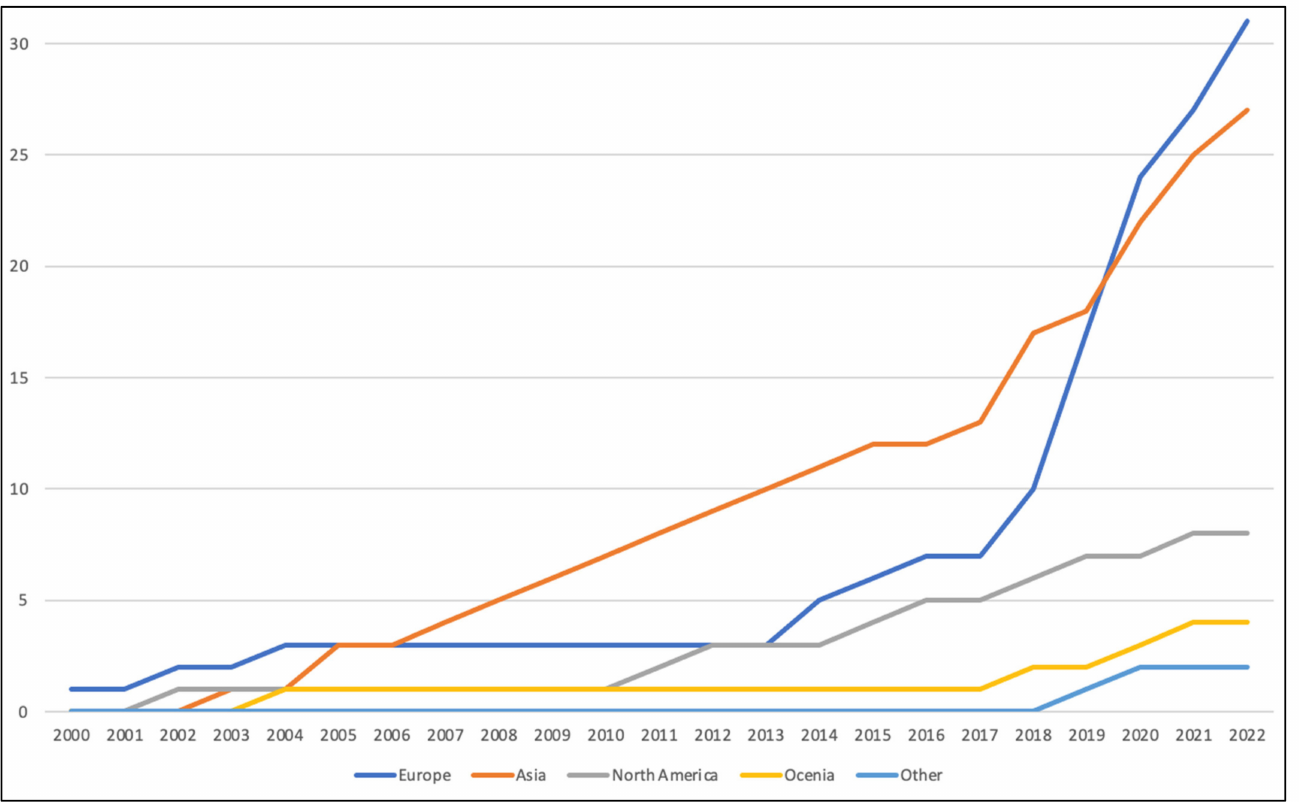
Figure 4. Distribution of publications by region and